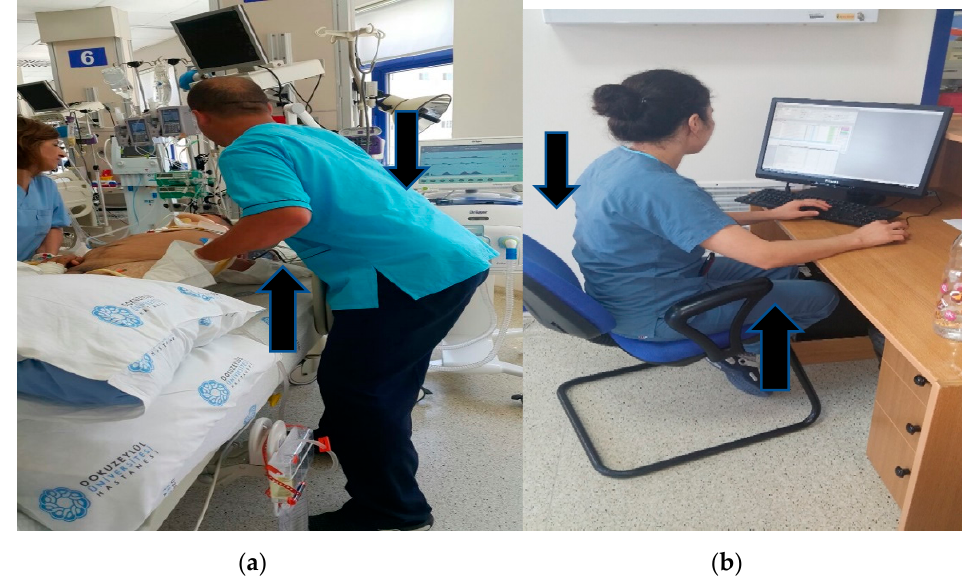
Figure 1. ( a ) Patient positioning and ( b ) working with the computer.